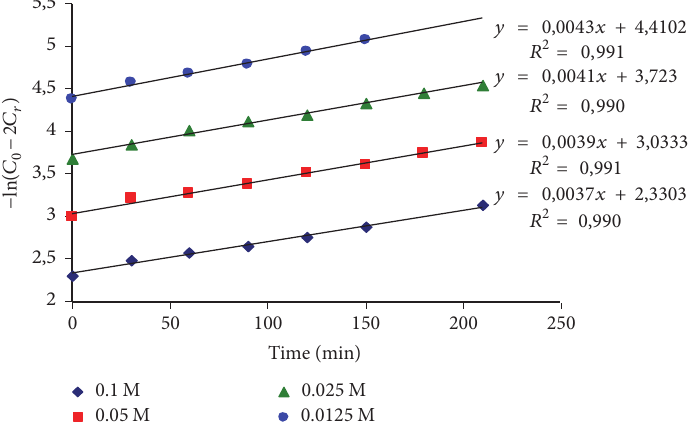
Figure 7: Evolution of the term − ln (𝐶 0 − 2𝐶 𝑟 ) versus time for facilitated extraction of VO 2+ ions by SLM containing extractive agent TOA. [H 3 O + ] = 1M, [TOA] = 10 −2 M, and T = 293